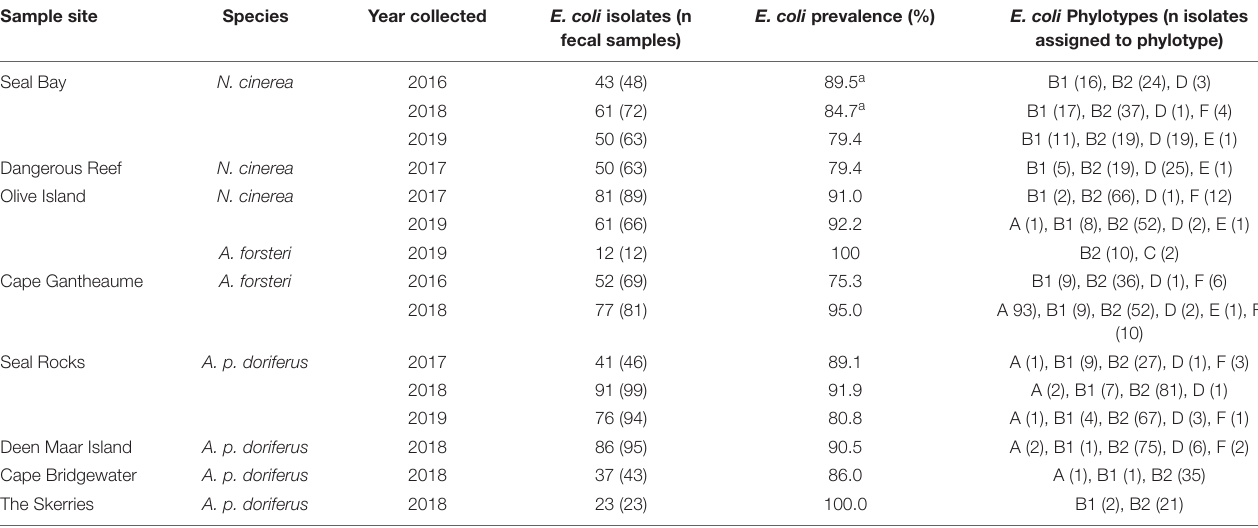
TABLE 2 | E. coli isolates and prevalence of E. coli in pinniped pups at all eight colonies sampled for each breeding season. Sample site Species Year collected E. coli isolates (n